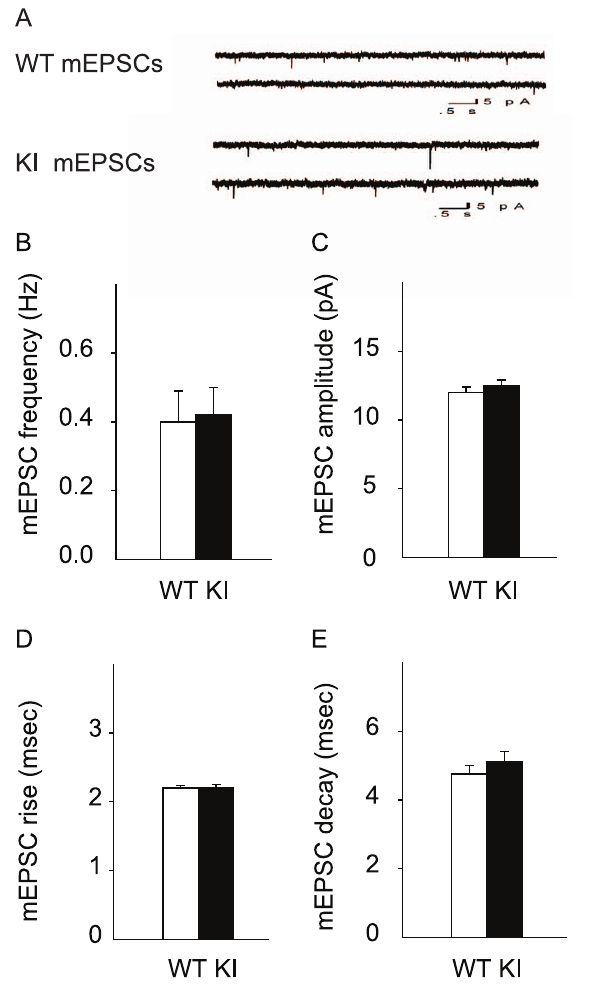
Figure 3. Normal mEPSCs in Dyt1 D GAG heterozygous KI mice. (A) Representative traces for mEPSCs. Dyt1 D GAG heterozygous KI mice had no change in frequency (B), amplitude (C), or rise (D) and decay (E) times of mEPSCs. The vertical bars represent means 6 standard errors.